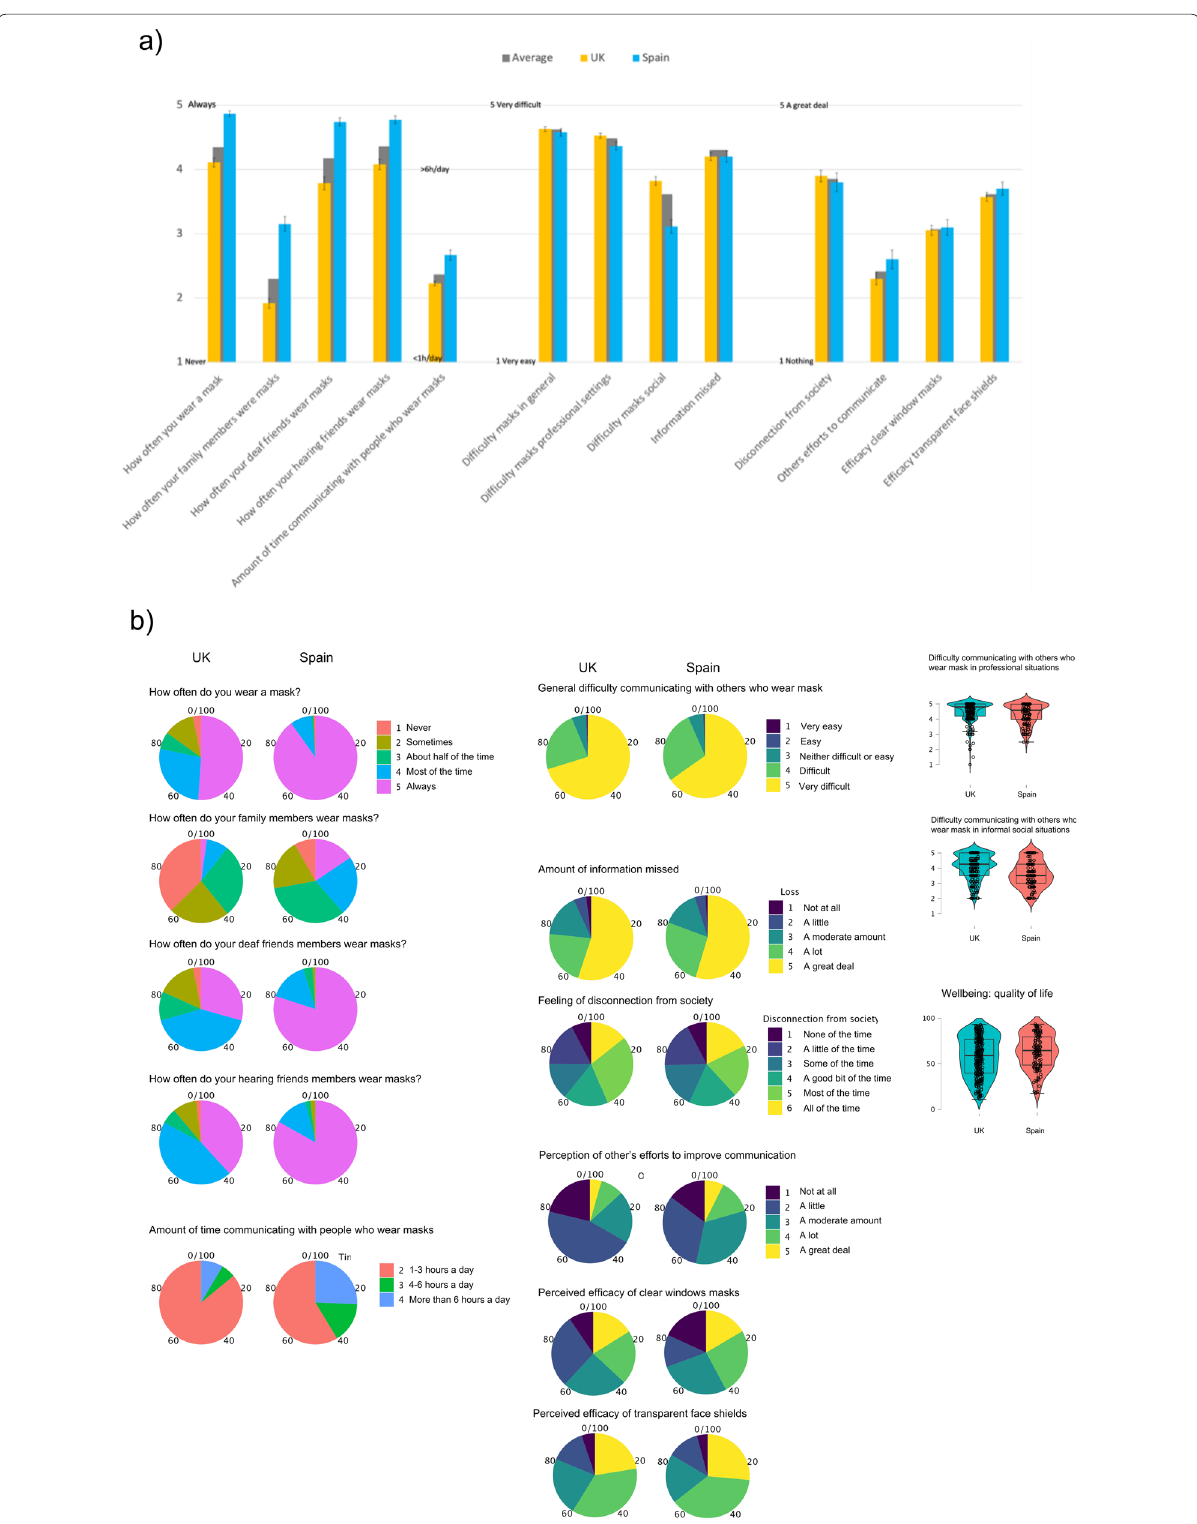
Fig. 1 a Mean responses to measures assessing frequency of interactions involving masks and to the study’s dependent variables. Mean values are shown for UK and Spanish residents separately, the grey bar in the background corresponds to the total average. b The distribution of responses to the same measures, a violin plot rather than a pie chart has been used for those measures that comprise continuous